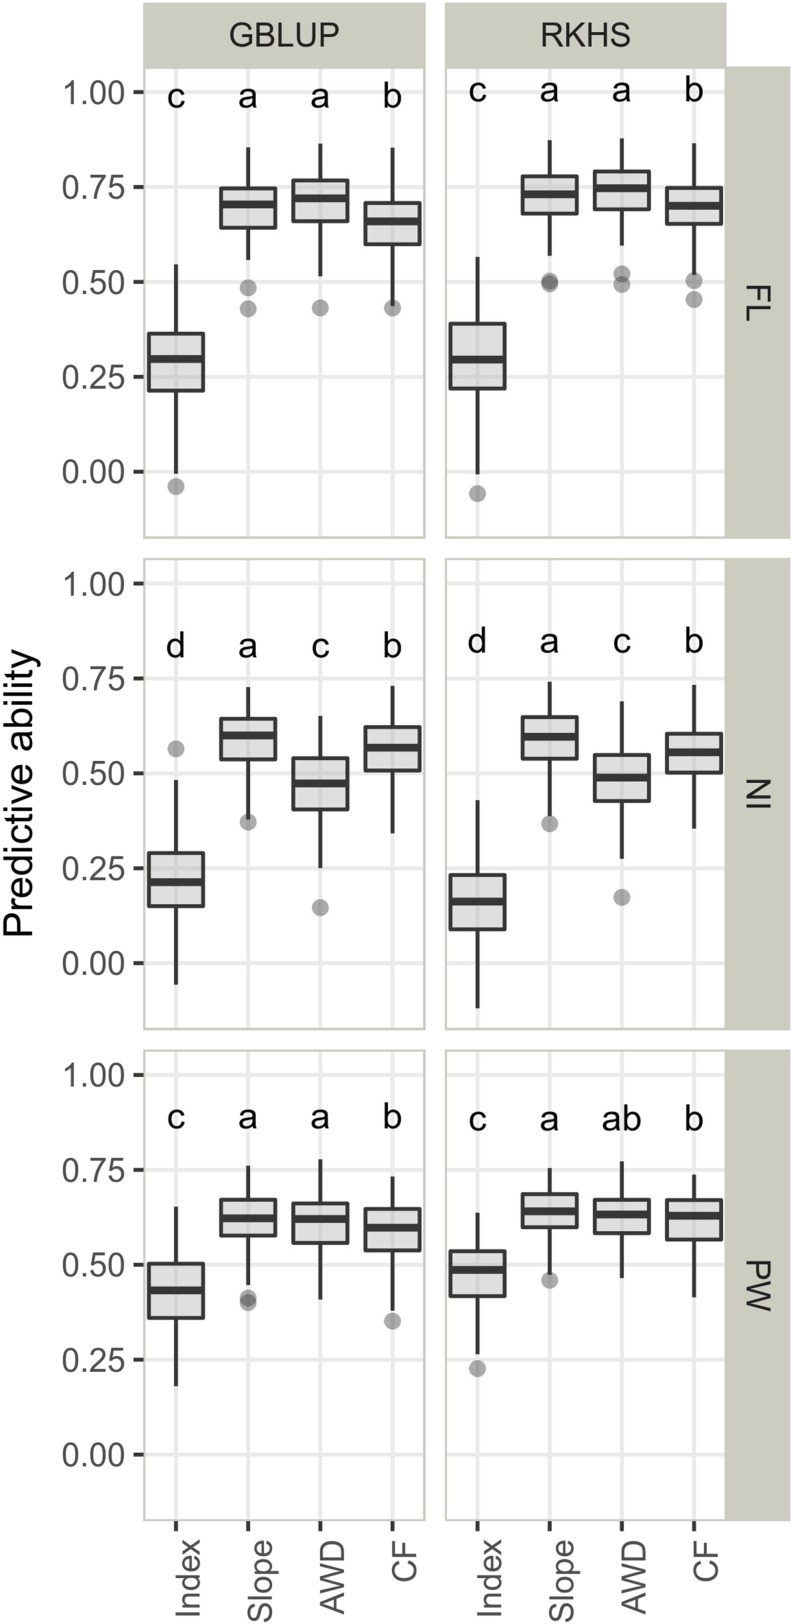
Predictive ability of genomic prediction in cross validation experiments within the reference population obtained with two statistical models (GBLUP, RKHS) for the response variables (index and slope) and the performance within each condition (continuous flooding – CF and alternate wetting and drying – AWD). The three traits are presented: days to flowering (FL), nitrogen balance index (NI) and panicle weight (PW). The letters in each panel represent the results of Tukey’s HSD comparison of means and apply to each panel independently. The means differ significantly (p-value < 0·05) if two boxplots have no letter in common.